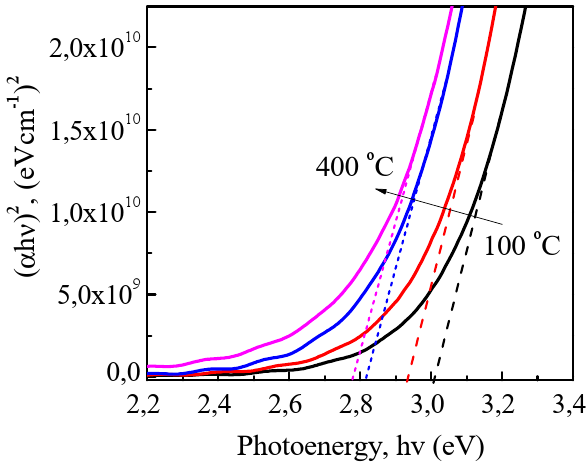
Figure 4. Electrical properties of Sb 0.14 GaN films deposited at different substrate temperature ranges of 100–400 °C.